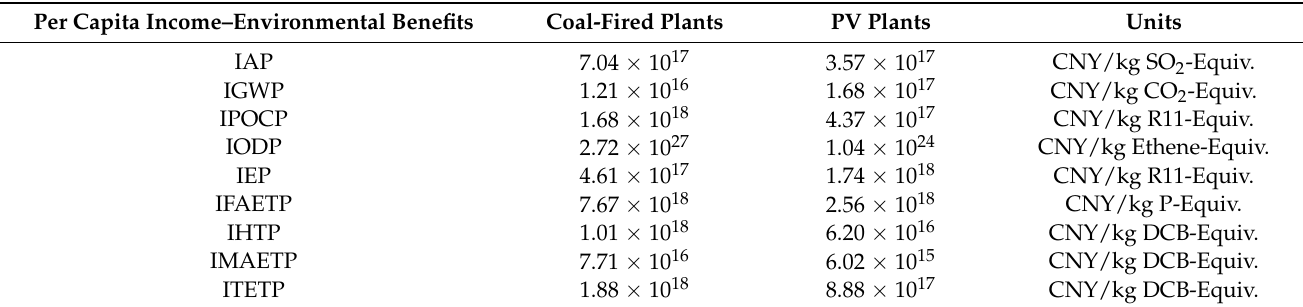
Table 9. Per capita income environmental benefits under two